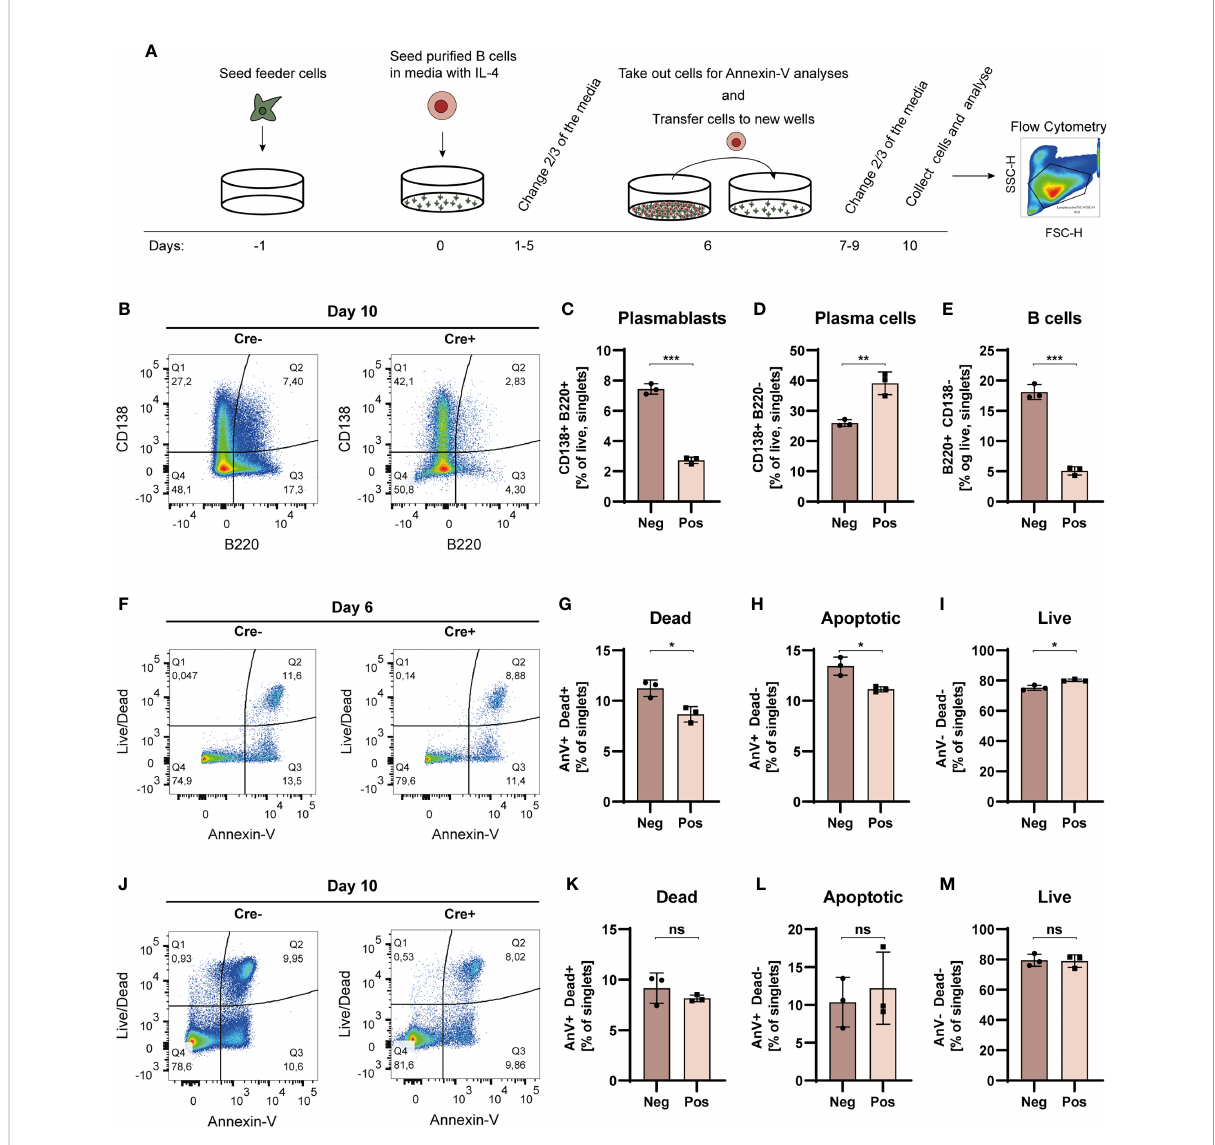
FIGURE 5 Bcl-6 de fi cient cells more readily differentiate into PCs in iGB cultures. (A) Schematic overview of the iGB culture system. (B) Representative terminal CD138 vs. B220 bivariate plot for iGB cultured B cells stimulated with IL-4. (C) Bar graph showing PB frequencies (B220 + CD138 + ). (D) As C, but showing PC frequencies (B220 neg CD138 + ). (E) As for C, but showing B cell frequencies (B220 + CD138 neg ). Data are representative of three independent experiments with a cumulative 8 replicates in total. Bar graphs show mean ± SD. (F) Day 6 representative terminal Live/Dead vs. Annexin V bivariate plot for iGB cultured B cells. (G) Bar graph showing dead cell frequencies (AnV + Dead + ). (H) As G, but showing apoptotic cell frequencies (AnV + Dead neg ). (I) As G, but showing live cell frequencies (AnV neg Dead neg ). (J) Day 10 representative terminal Live/Dead vs. Annexin V bivariate plot for iGB cultured B cells. (K) Bar graph showing dead cell frequencies (AnV + Dead + ). (L) As K, but showing apoptotic cell frequencies (AnV + Dead neg ). (M) As K, but showing live cell frequencies (AnV neg Dead neg ). Data for apoptosis assays are from one experiment with 3 replicates. Bar graphs show mean ± SD. Unpaired t-tests were used to analyze all datasets. ns = p ≥ 0.05, *p < 0.05, **p < 0.01, ***p <